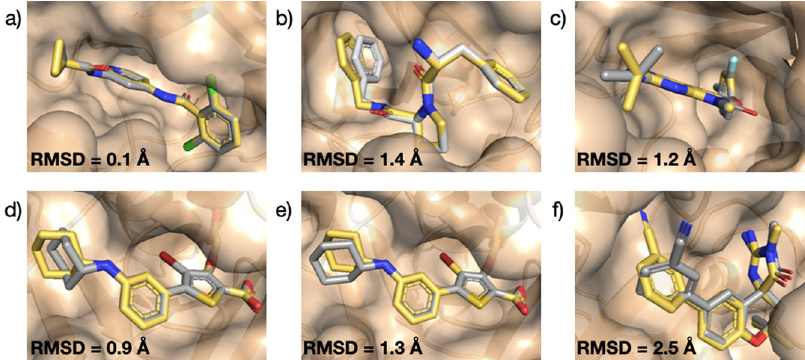
Fig. 2 Overlay of experimental and predicted protein-ligand benchmark dataset structures. Crystal structures are shown in yellow and grown compounds in grey. a TYK2 (PDB: 4GIH 59 ), b Thrombin (PDB: 2ZFF 60 ), c P38 (PDB: 3FLY 61 ), d PTP1B with force fi eld optimisation (PDB: 2QBS 62 ), e PTP1B using ML/MM optimisation, and f BACE(Hunt) (PDB: 4JPC 63 ). Root-mean-square distances (RMSD) between predicted and experimental coordinates of atoms in the built R-groups were calculated using RDKit 32